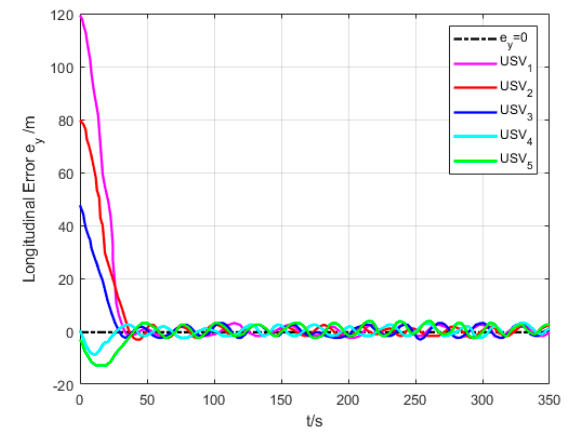
Figure 19. Longitudinal error (Algorithm 3).